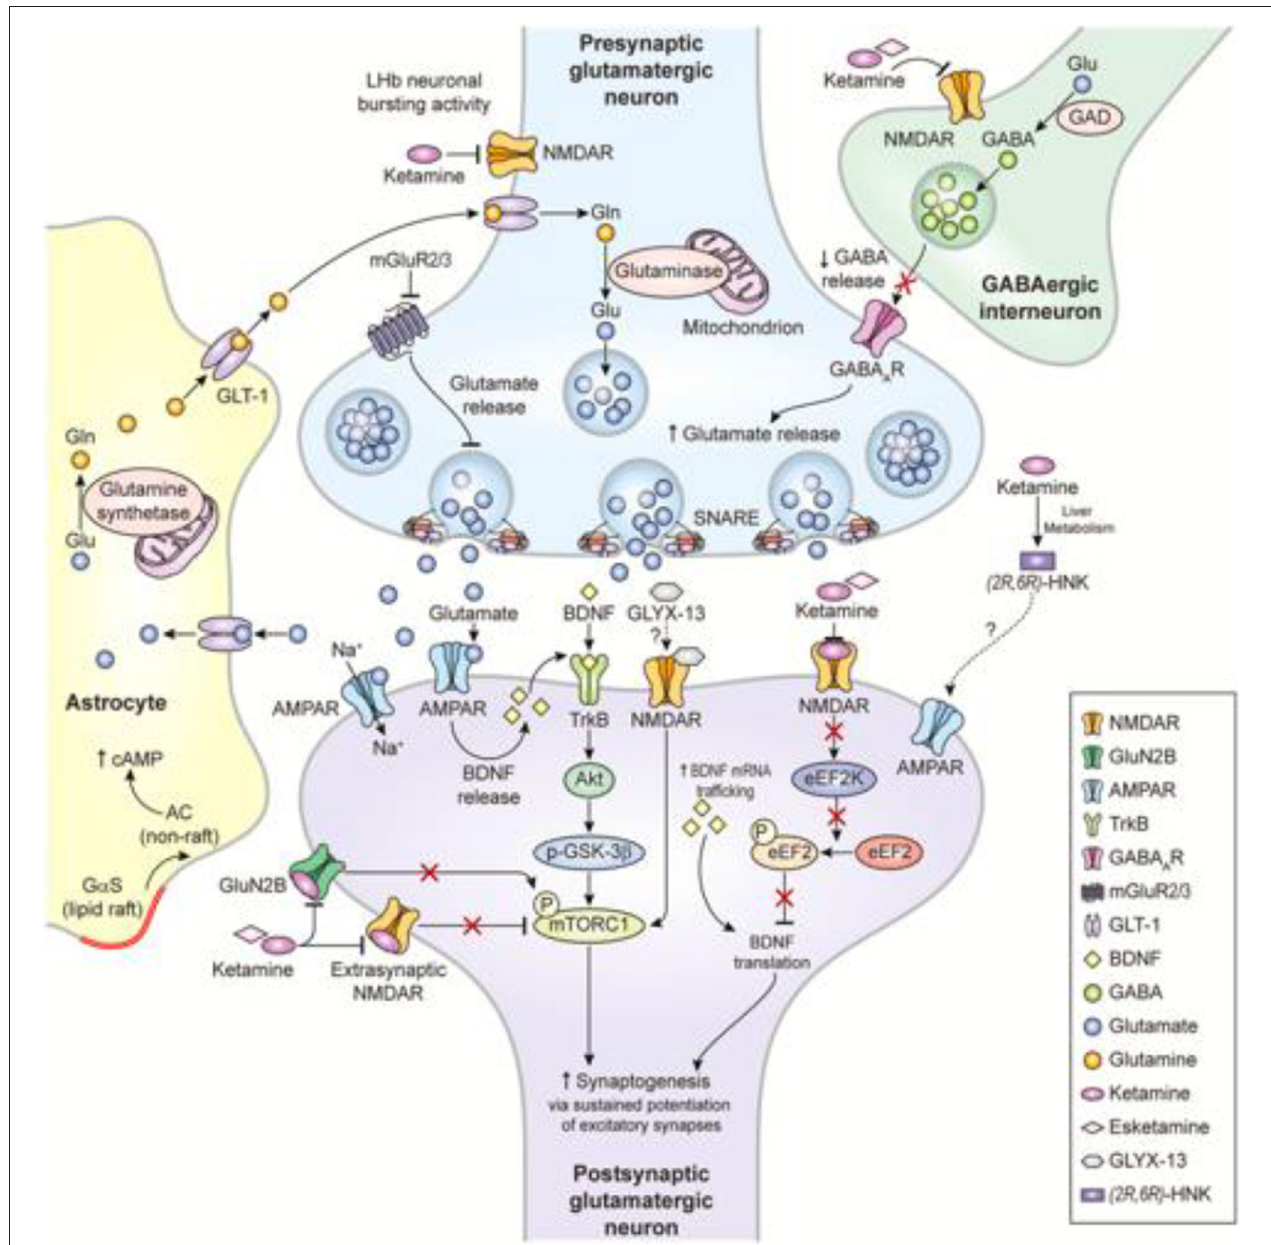
FIGURE 1 | Proposed mechanisms of action of glutamatergic modulators and other putative rapid-acting antidepressants (10).